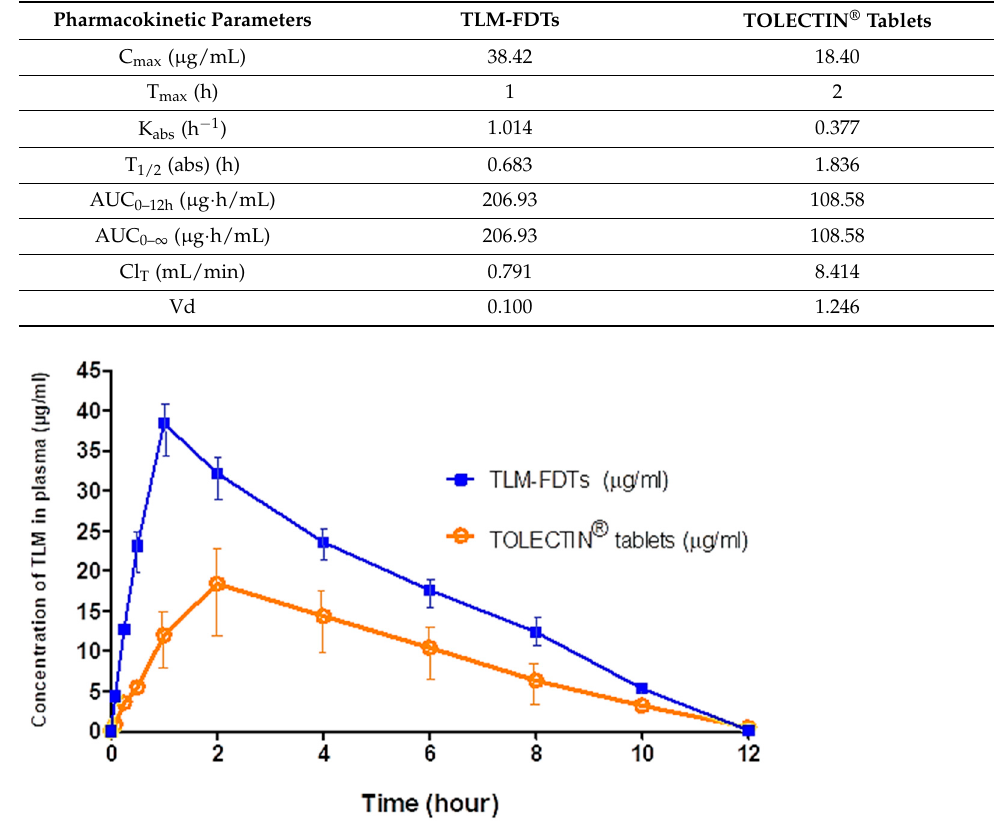
Figure 11. The mean concentration ‐ time curve of TLM ( μ g/mL) in plasma after oral administration of TOLECTIN ® tablets and TLM ‐ FDTs in rats. Data are presented as the mean ± SD ( n = 3). Table 6. The plasma pharmacokinetic characteristics of TLM ‐ FDTs and Tolectin ® tablets in rats after oral delivery.